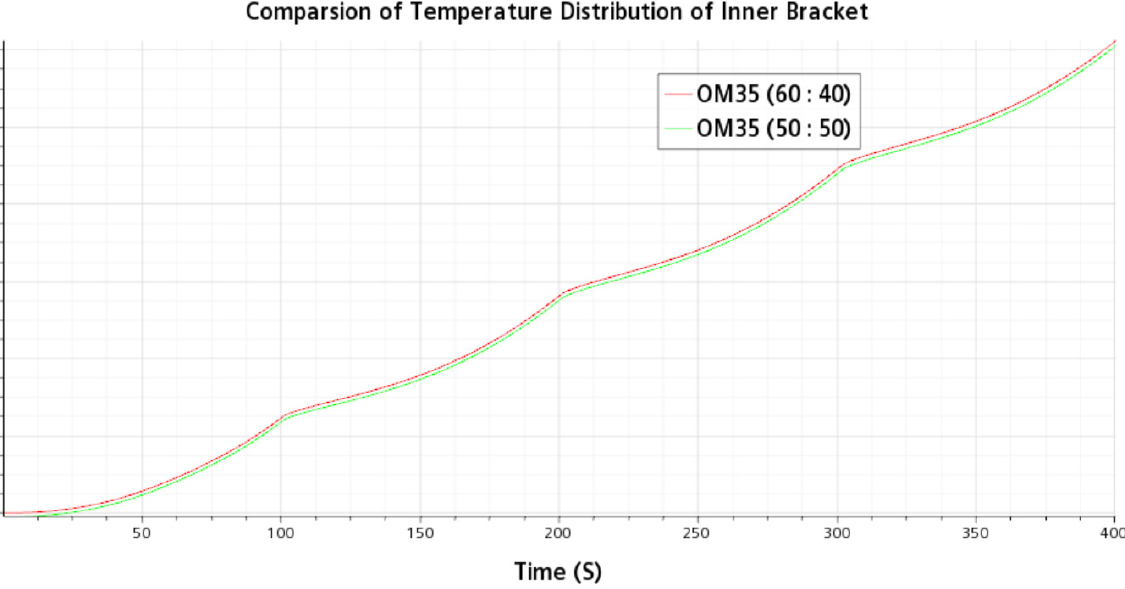
Figure 21. Comparison of temperature distribution of outer bracket plot over time for different PCM material.